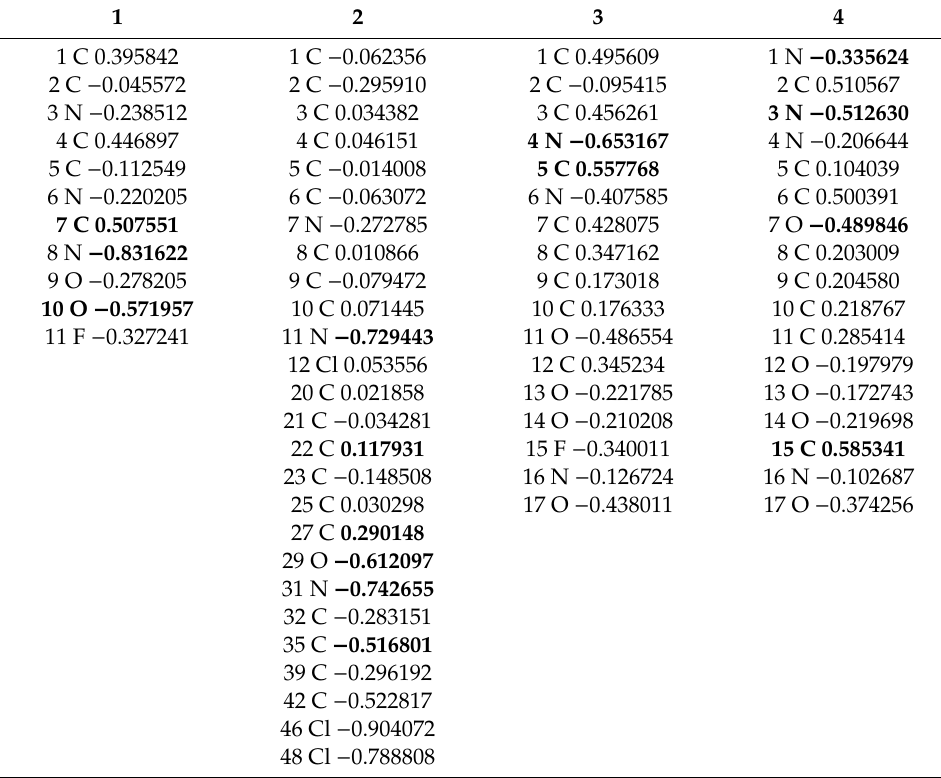
Table 3. The Mulliken atomic charges of the estimated drugs 1 – 4